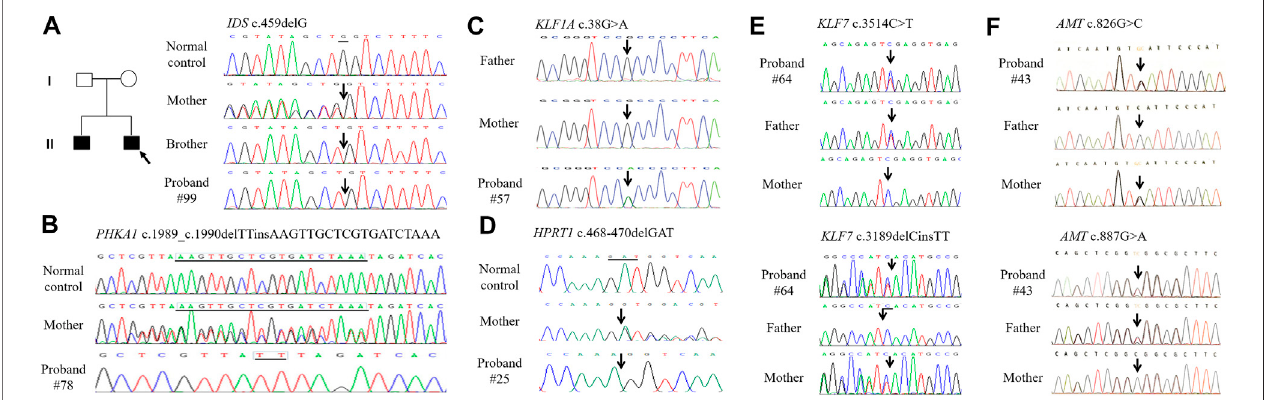
FIGURE3| TheDNA sequence chromatogramsofDNAsequences showingsequence variants inID patients. (A) .Patient #99and his brother carryheterozygous deletionc.459delG inIDS. (B) .Patient#78carries heterozygousindel c.1989_c.1990delTTinsAAGTTGCTCGTGATCTAAAinherited fromthe healthymother inPHKA1. (C) . Patient #57 carries de novo missense c.38G > A in KIF1A. (D) . Patient #25 carries hemizygous deletion c.468_470delGAT in HPRT1. (E) . Patient #64 carries compound heterozygous sequence variants c.3514C > T and c.3189delCinsTT in KIF7. (F) . Patient #43 carries compound heterozygous sequence variants c.826G > C and c.887G > A in